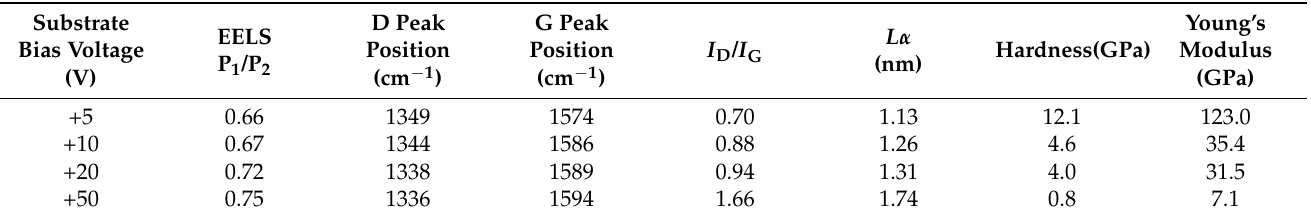
Table 1. EELS, Raman, and mechanical parameters of the carbon films produced at different substrate bias